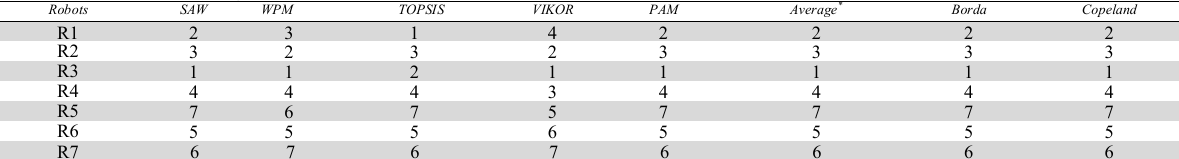
The results of average of SAW; WPM; TOPSIS and VIKOR methods ranks Robots SAW